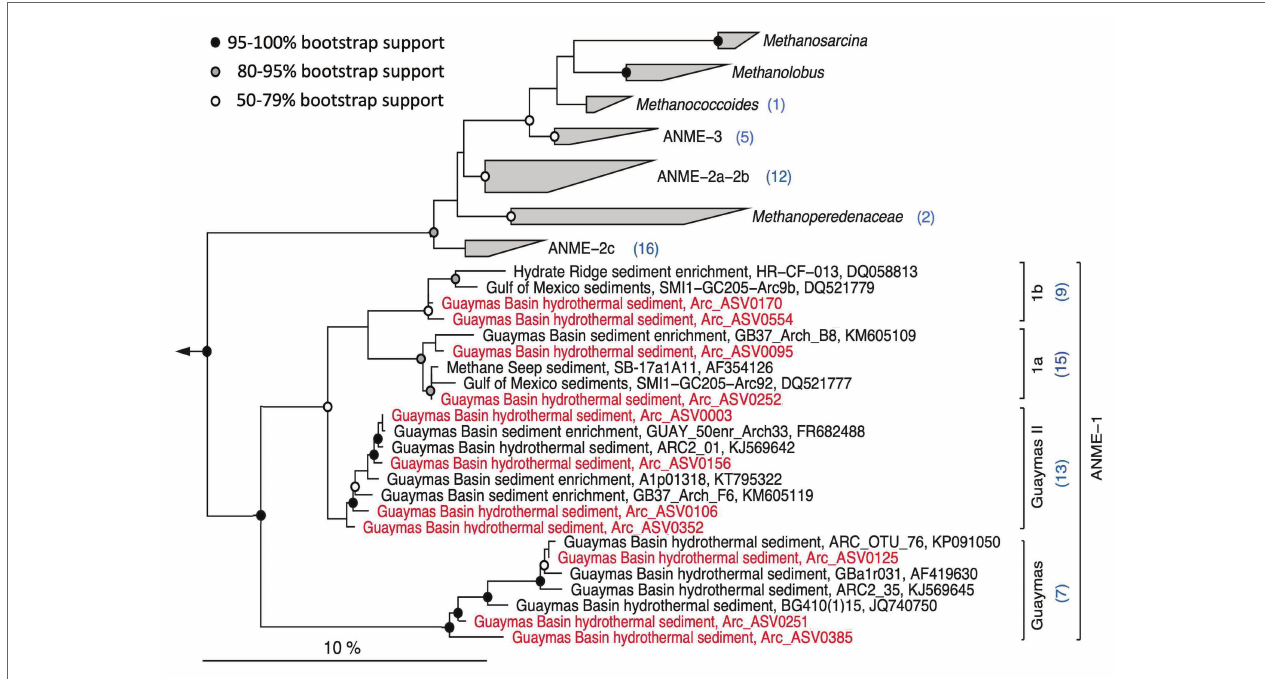
FIGURE 10 | Maximum likelihood phylogeny of ANME-1 archaea and related ANMEs and methanogens. The tree was calculated using near full-length sequences; partial 16S rRNA gene sequences (ca. 450 nucleotide positions) obtained with primers 517F and 958R were added without changing the tree topology. The annotation numbers in parentheses indicate the number of representative ASVs for different clades. Sequences used for the phylogeny are listed in Supplementary Table S5 for easy